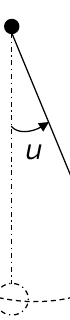
Figure 6. Responses of the pendulum using the trapezoidal rule with  = 0 . 15 s t .